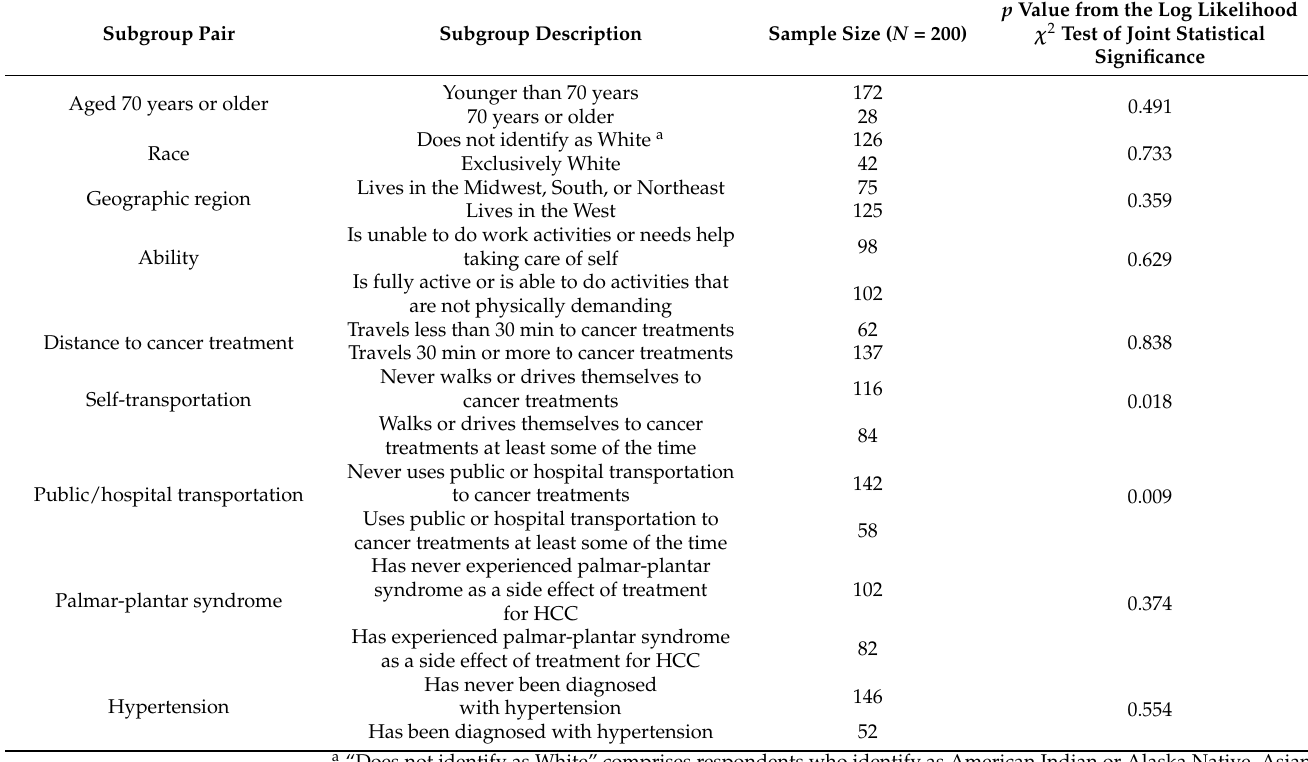
Table A2. Descriptions of the Subgroups Analyzed ( N =